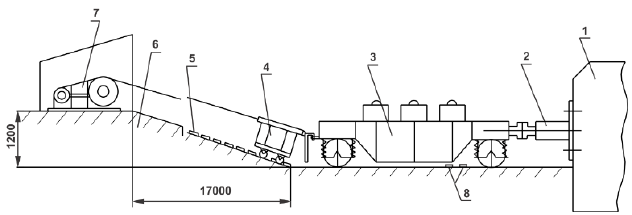
Figure 5. Compressive test bench for buffer static testing.